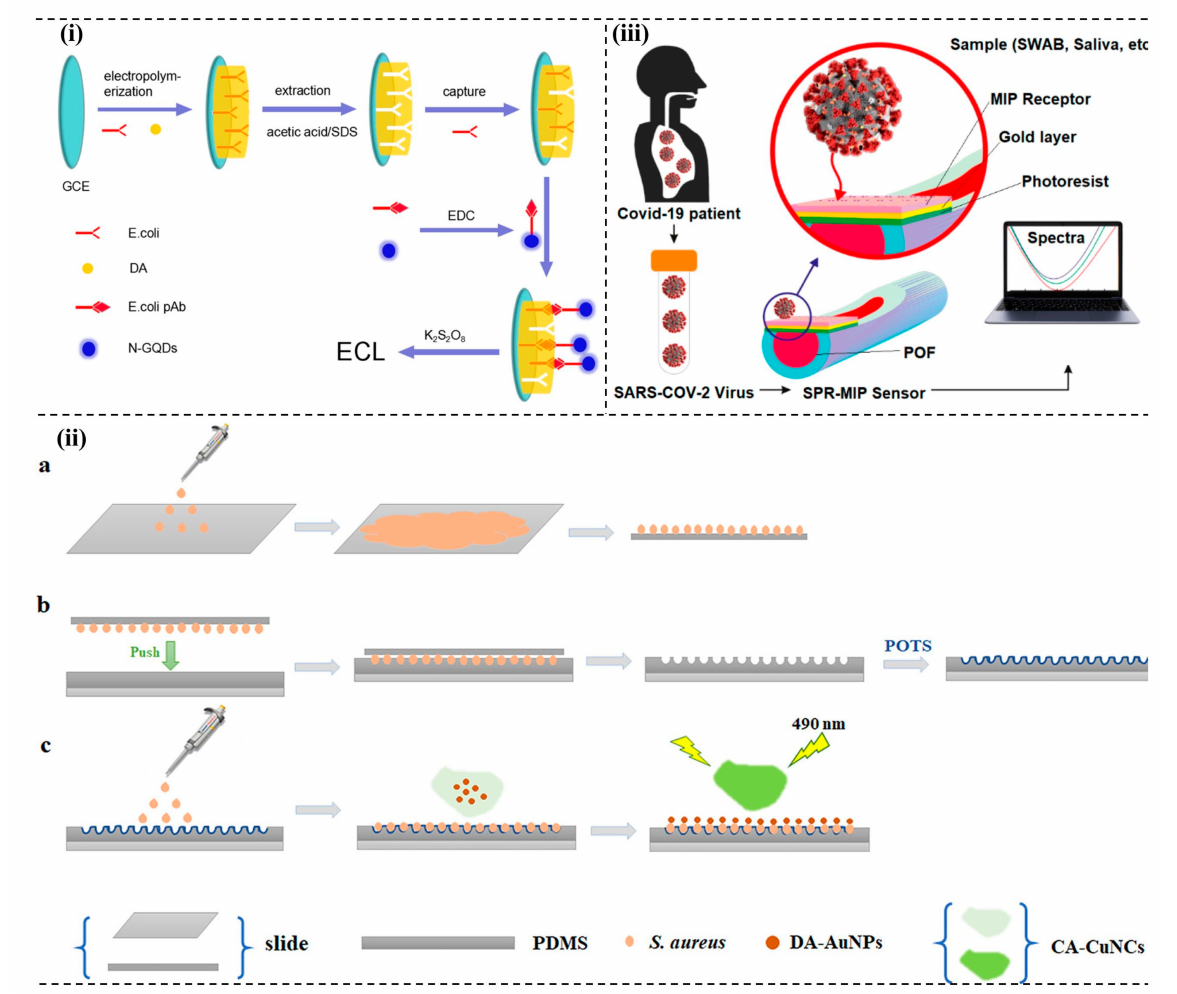
Figure 3. MIP-based pathogen detection system. ( i ) Fabrication schemes and detection of E. coli following ECL principles. Reprinted with permission from Ref. [134]. Copyright 2017